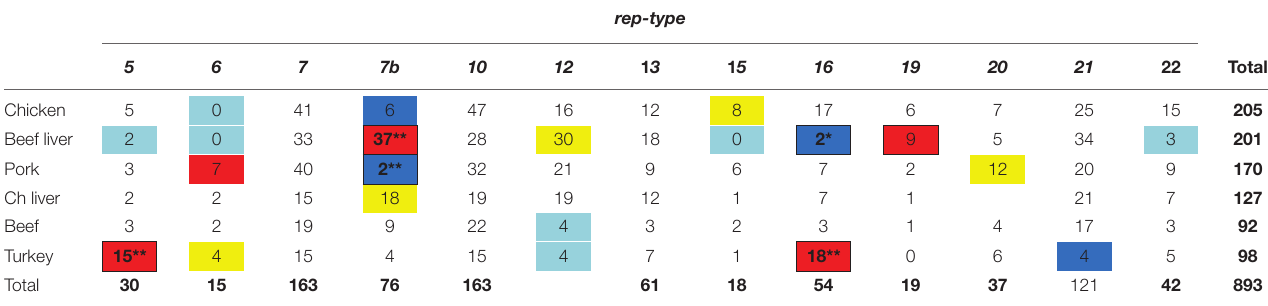
FIGURE 4 | The variation in numbers of plasmid rep types per a single S. aureus isolate. The frequency refers to counts of isolates with particular rep type numbers. Here, more rep types were seen than the number of isolates as some isolates contained more than one rep type. TABLE 2 | Data used for the chi-square test of independence between rep-type and meat